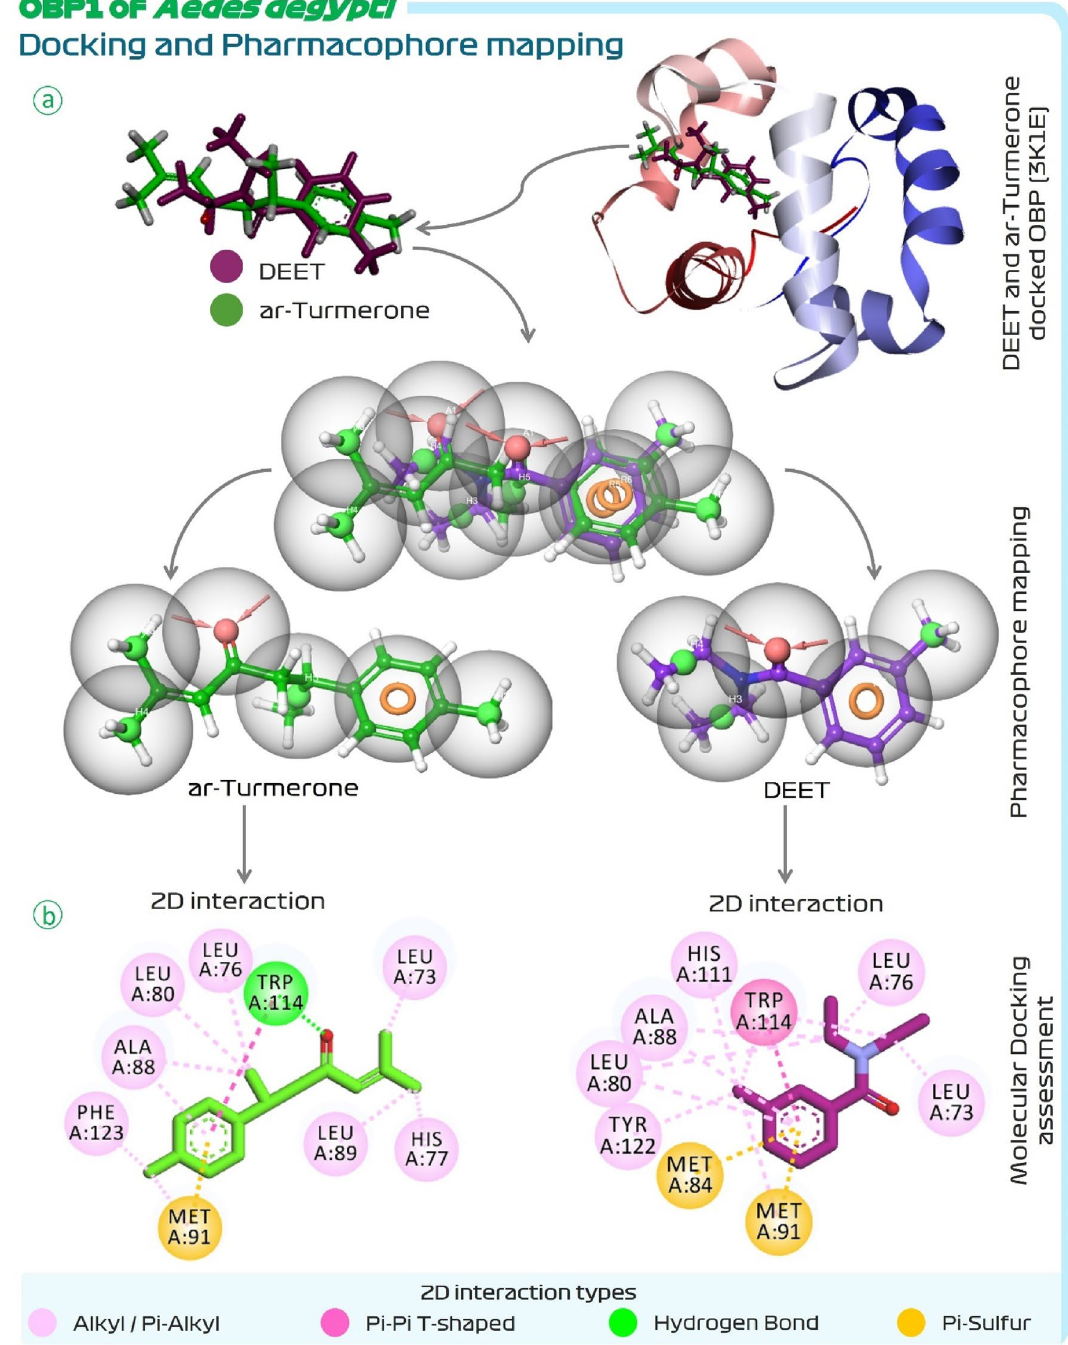
Figure 3. ( a ) Pharmacophore feature mapping and ( b ) molecular docking of DEET and ar-turmerone with OBP1 (3K1E) of A. left Y-axis, variations in the range of 1 Å to 4 Å are totally reasonable; however, based on the different protein sizes, the range may expand. However, much larger changes indicate a significant structural shift in protein dur- ing MD recordings. In this case, for OBP1, the RMSD value never exceeds 3 Å, indicating that protein stability is satisfactory. The RMSD of the ligand, which is a measure of how stable the ligand (DEET) is bound at the catalytic site of OBP1, is shown on the right Y-axis. The value of ’Lig fit Prot’, as this value doesn’t exceed considerably than the Protein RMSD, is acceptable. Similar findings of RMSD were also seen for the ar-turmerone-OBP1 complex represented in Fig. 5. Next, the interaction of DEET with OBP1 in detail be understood by protein ligand interaction summary image as shown in Fig. 4 and for ar-turmerone with OBP1 in Fig. 5, which shows interaction prevailing between ligand and protein during the MD simulation run, here it is observed that DEET and ar-turmerone both recruits Trp114 efficiently with their aromatic rings. Further it is observed that ketone